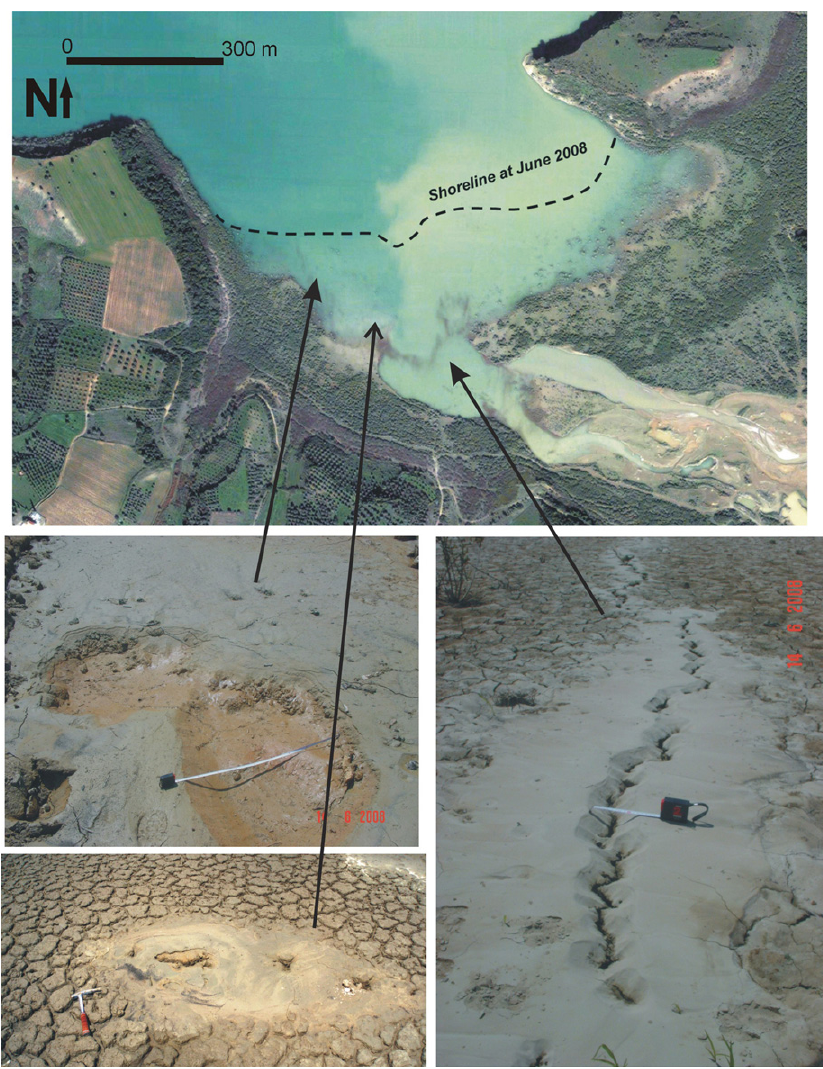
Figure 6. Liquefaction manifestation at the area of Roupakia. Sand craters with a diameter up to 85 cm (top left); Vent fractures 85 cm (right); Sand volcanoes (bottom